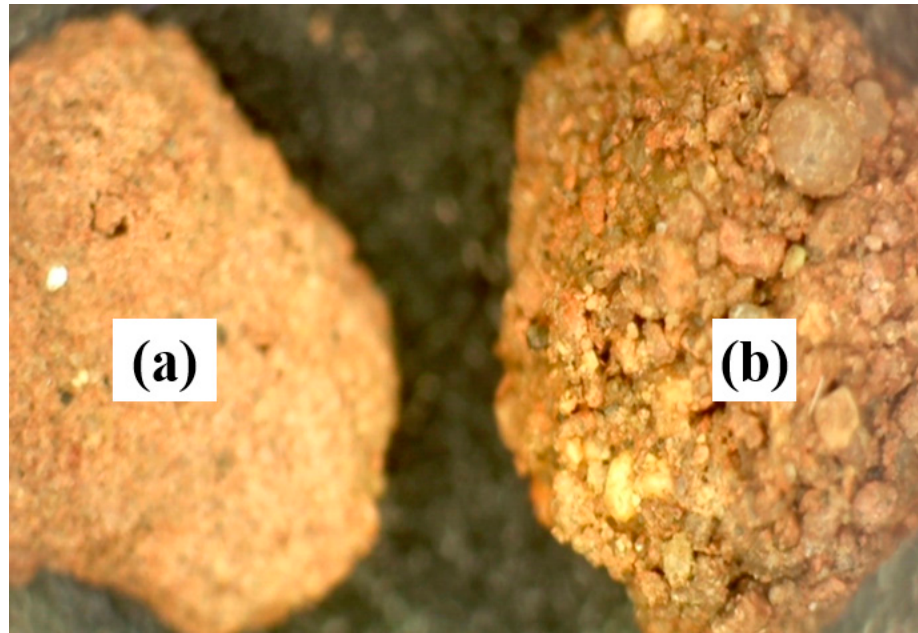
Figure 12. Visual inspection (×60) of ( a ) uncoated soil particle and ( b ) soil sample coated with 12% coating solution.